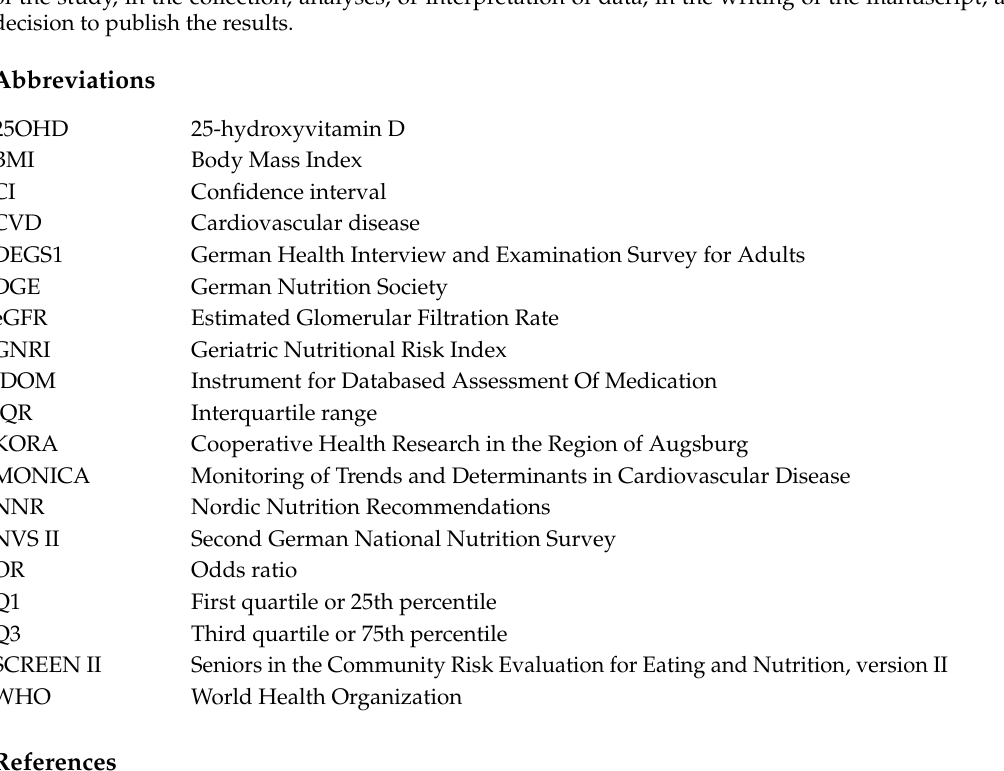
Figure S1: Flowchart of the KORA-Age 2008/2009 recruitment and retention profile, Table S1: Description of data collection and categorization methods for the investigated predictors in KORA-Age 2008/2009, Table S2: Unadjusted ORs with 95% CIs for subclinical micronutrient deficiencies by categories of potential predictors: Results from binary logistic regression analyses in KORA-Age 2008/2009, Table S3: Predictors with p < 0.25 in binary logistic regression which were entered into each multiple logistic regression